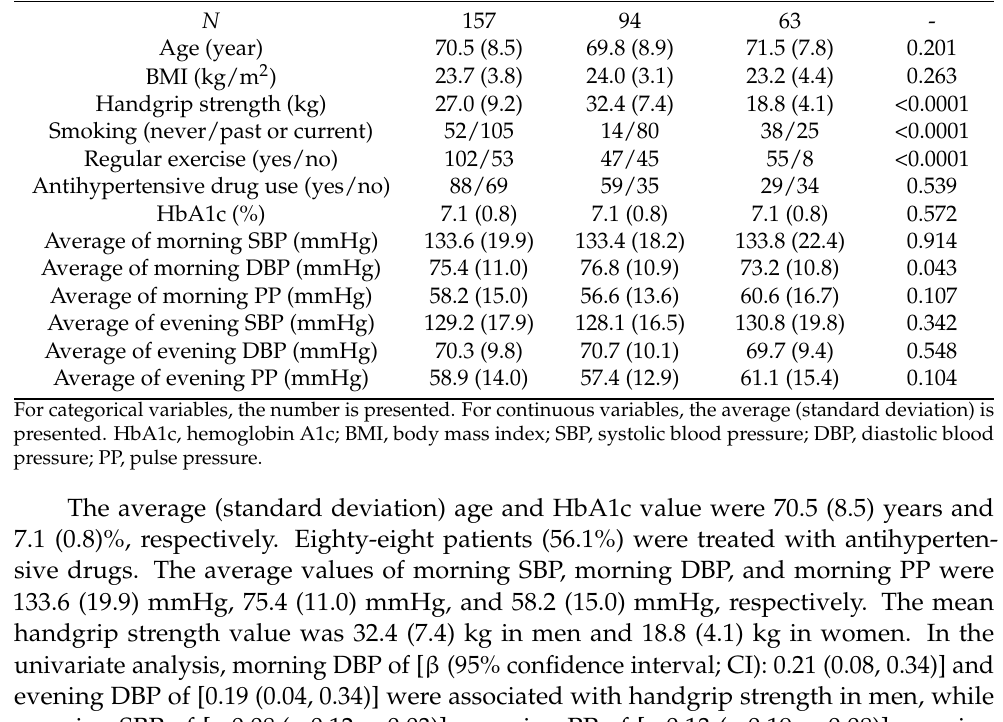
All Men Women p